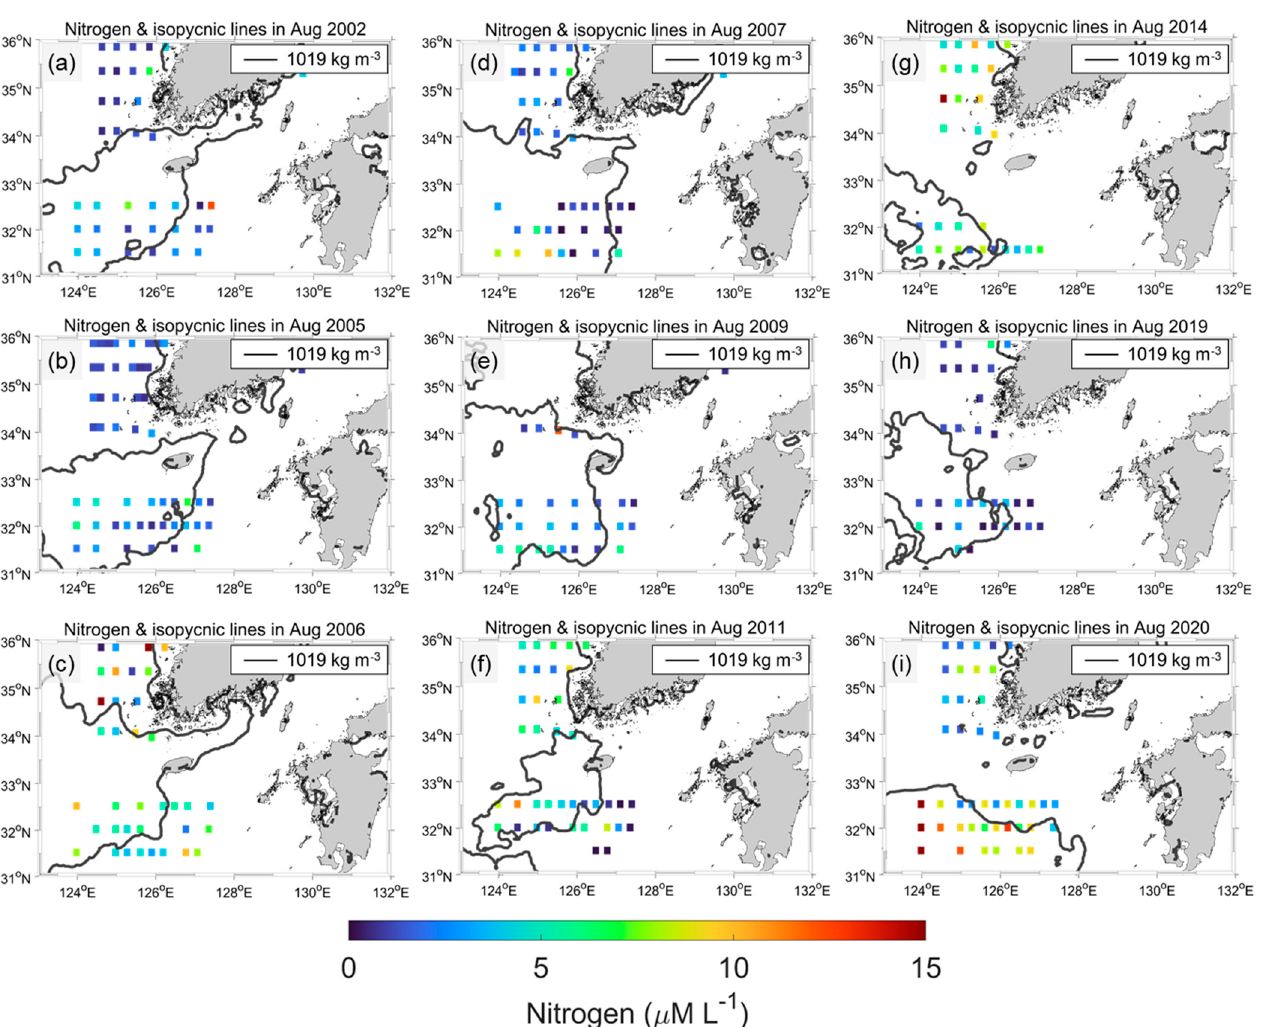
Figure 9. ( a – i ) In situ nitrogen concentration (colored square) and 1019 isopycnic line during Au- gust 2002, 2005, 2006, 2007, 2009, 2011, 2014, 2019, and 2020. Nitrogen resulted from NIFS serial shipboard observations.